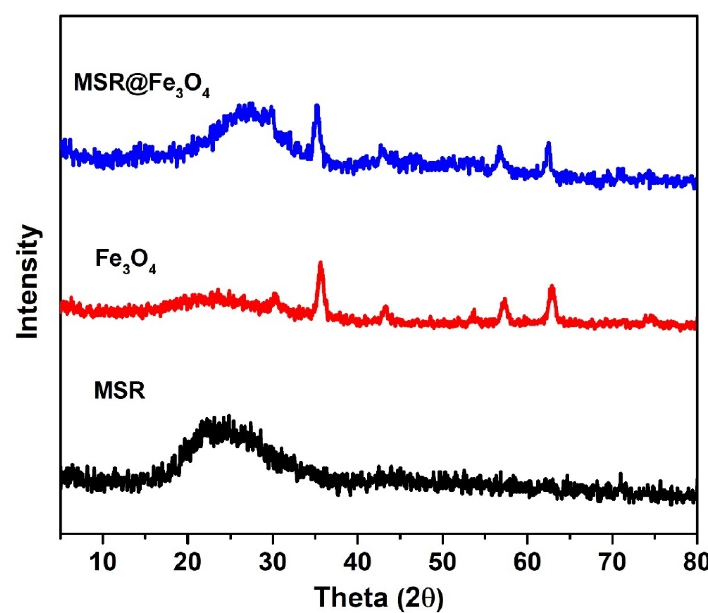
Figure 3. XRD pattern of monodisperse Fe 3 O 4 NPs, MSR ‐ COOH and Fe 3 O 4 grafted MSR.